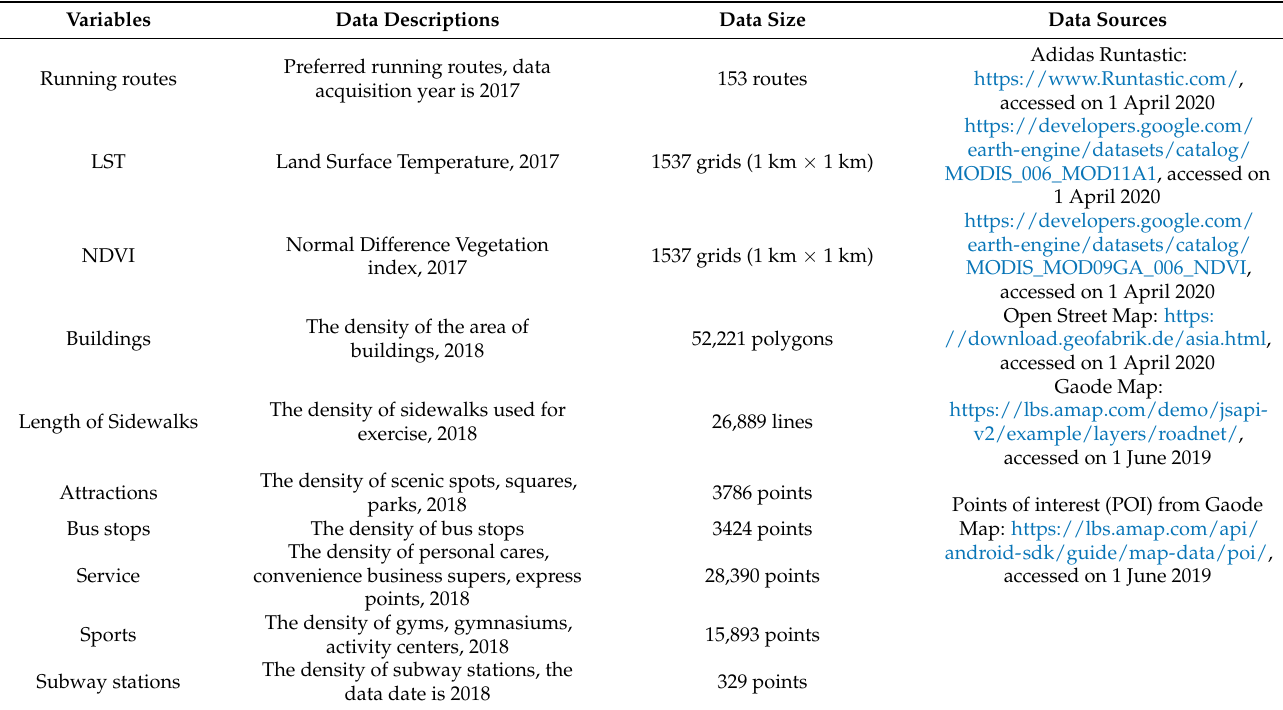
Table 2. The information of running routes data and